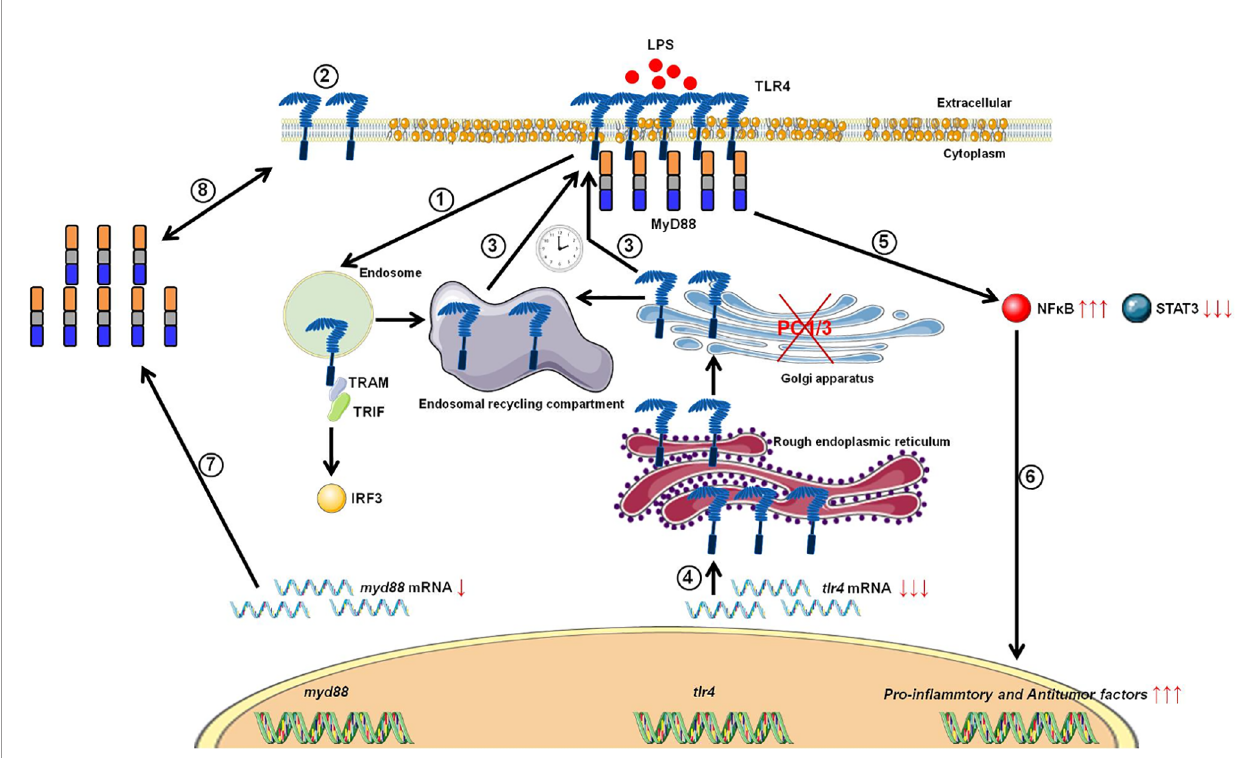
FIGURE 3 | Proposed model depicting the impact of PC1/3 knockdown on the activation of TLR4. Yellow droplets in the cell membrane symbolize that KD cells exhibited modi fi cations of their lipid pro fi le. (1) After LPS treatment, TLR4 is internalized in the endosomes to trigger the MYD88-independentsignaling resulting in the activation of IRF-3. (2) As a result, the level of TLR4 at the plasma membrane decreases. (3) In the absence of PC1/3, TLR4 is more quickly re-expressed at the cell surface as symbolized by the clock pictogram, i.e ,. 3 h after LPS treatment. These receptors may translocate from endosomal recycling compartment (ERC) where they are stored or from the Golgi apparatus after their synthesis and maturation. (4) TLR4 receptor can be synthesized from a pre-existing pool of messengers. This may support the de novo expression of the receptor at the cell surface or the replenishment ofTLR4 stock in ERC if the receptor translocated from this compartment. (5) The re-expression of TLR4 at the cell surface after 3 h of LPS challenge in PC1/3 KD macrophages leading to a stronger activation of the pro- in fl ammatory NFKB pathway while the anti-in fl ammatory STAT3 pathway is downregulated. (6) As a consequence, PC1/3 KD macrophages stimulated with LPS secrete more pro-in fl ammatory cytokines and antitumor factors. After treatment of PC1/3 KD cells with LPS during 6 h, TLR4 is again internalized, and its amount at the cell surface decreased (2). (7) The increase of MYD88 level observed in PC1/3 KD macrophages after 6 h of LPS treatment may compensate the decrease of TLR4 at the cell surface and maintain the activation of the signaling pathway. (8) A clear correlation between protein synthesis and gene expression in KD cells treated with LPS cannot be made. Therefore, another mechanism, such as augmentation of protein half-life or stability may be responsible for this increase. (9)